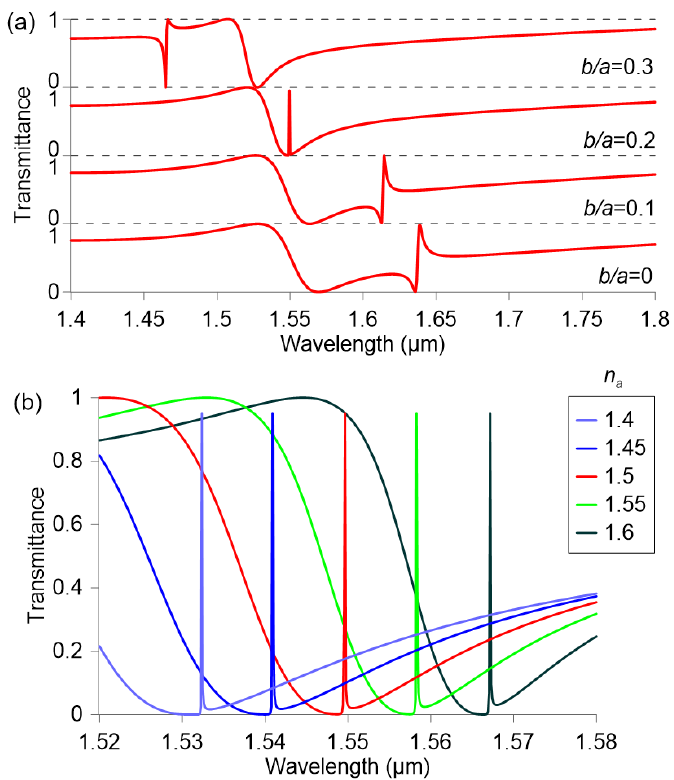
Figure 5. Transmittance of a metasurface composed by silicon nanocuboids ( h = 361 nm, h / a = 0.64, g = 50 nm) patterned on a glass substrate for ( a ) different relative hole size ( n a = 1.5) and ( b ) different analyte refractive index ( b / a =